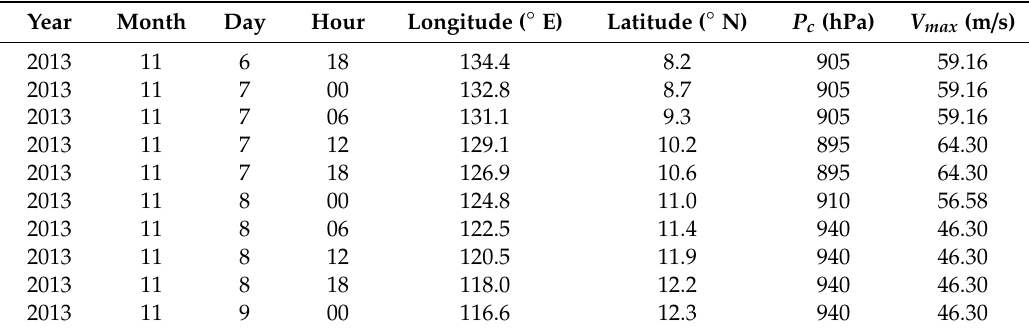
Table 1. Strom track parameters of 2013 Typhoon Haiyan from the JMA best-track database, provided in every 6 h. In this table, the maximum wind speeds of Haiyan are converted to the SI unit, m / s. The time zone of this table is UTC + 0 time. P c indicates the central pressures of Haiyan, and V max depicts the maximum sustained wind